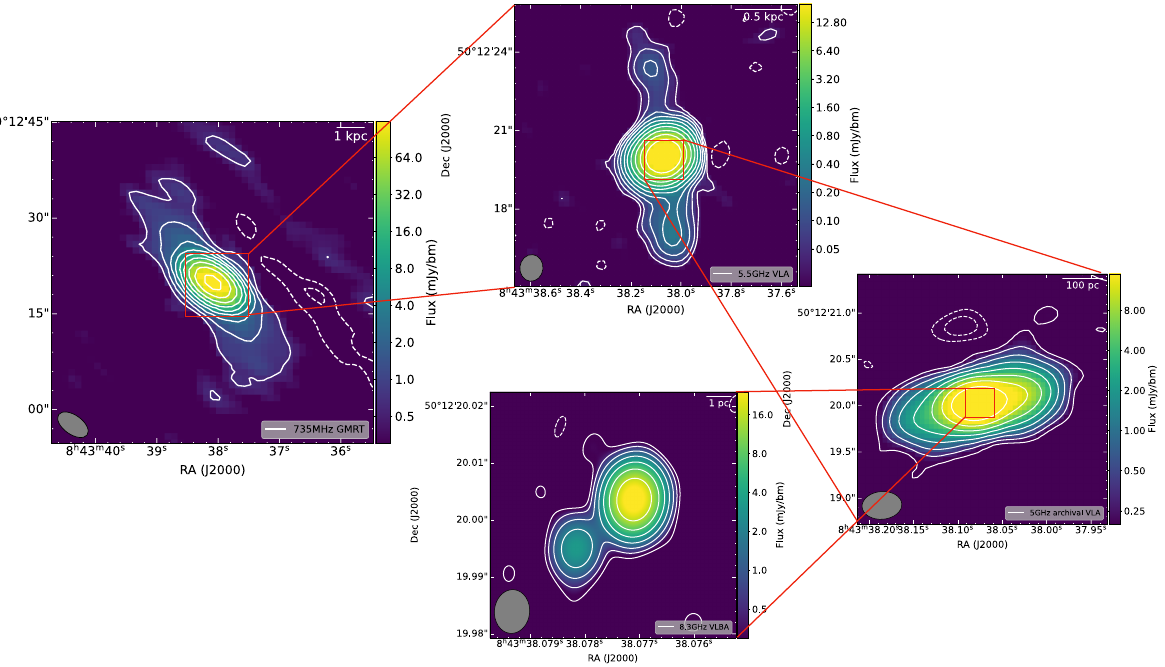
Figure 2. The four AGN jet episodes of NGC2639. (Left) 735 MHz GMRT total intensity image. The ∼ 9 kpc radio lobes are seen in this image. Contour levels: ( − 2, − 1,1,2,4,8,16,32,64,128,256 ) × 0.6 mJy beam − 1 . The beam at the bottom left corner is of size: 5.48 arcsec × 3.0 arc- sec at PA = 54.6 degrees. (Top) 5.5 GHz VLA total intensity image. Contour levels: ( − 2, − 1,1,2,4,8,16,32,64,128,256,512 ) × 0.03 mJy beam − 1 . The ∼ 1.5 kpc north-south radio jets are seen here. Beam size: 1.02 arcsec × 0.89 arcsec at PA = − 5.8 degrees. (Right) 5 GHz VLA ra- dio image. Contour levels: ( − 2, − 1,1,2,4,8,16,32,64,128 ) × 0.164 mJy beam − 1 . The ∼ 360 parsec east-west lobes are seen in this image. Beam size: 0.43 arcsec × 0.30 arcsec at PA = − 85.4 de- grees. (Bottom) 8.3 GHz VLBA image showing a ∼ 3 parsec jet at PA = 130 degrees. Contour levels: ( − 2, − 1,1,2,4,8,16,32,64 ) × 0.239 mJy beam − 1 . Beam size: 7.7 mas × 6.2 mas at PA = − 4.9 degrees. Figure reproduced from Rao et al. [45]. A ∼ 6 kpc hole in the molecular gas distribution is observed in the central regions of